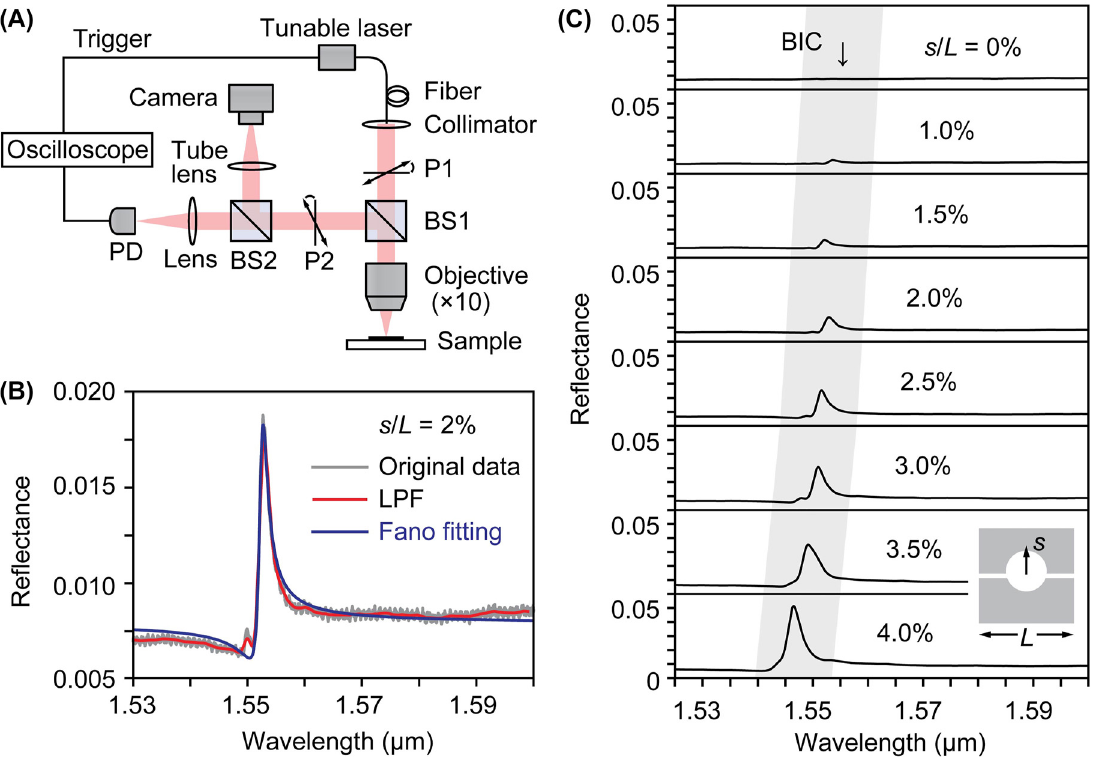
Figure 5: Reflectance measurements in water at normal incidence using a home-built setup. (A) Experimental setup for the reflectance measurement. P1 and P2: polarizers; BS1 and BS2: beam splitters; PD: photodiode. (B) Reflectance spectrum for the metasurface ( s / L = 2%) with nanogaps measured in water. (C) Spectra of the MD mode with different asymmetries s / L . The vertical thick grey line represents guide to the